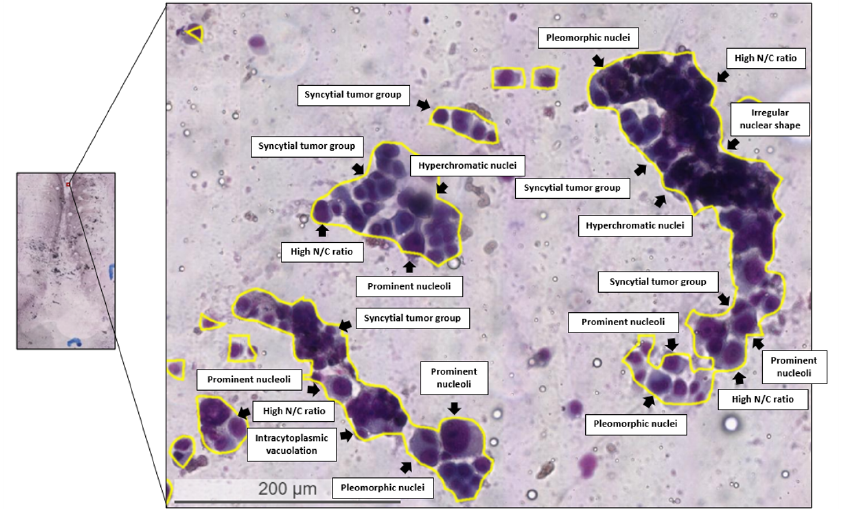
Figure 8. Pathologist’s assessment of automatic predictive results generated by the proposed method with typical lung adenocarcinoma features required to generate a diagnostic evaluation, including syncytial tumor group, hyperchromatic nuclei, high N/C ratio, prominent nucleoli, irregular nuclear shape, pleomorphic nuclei, and intracytoplasmic